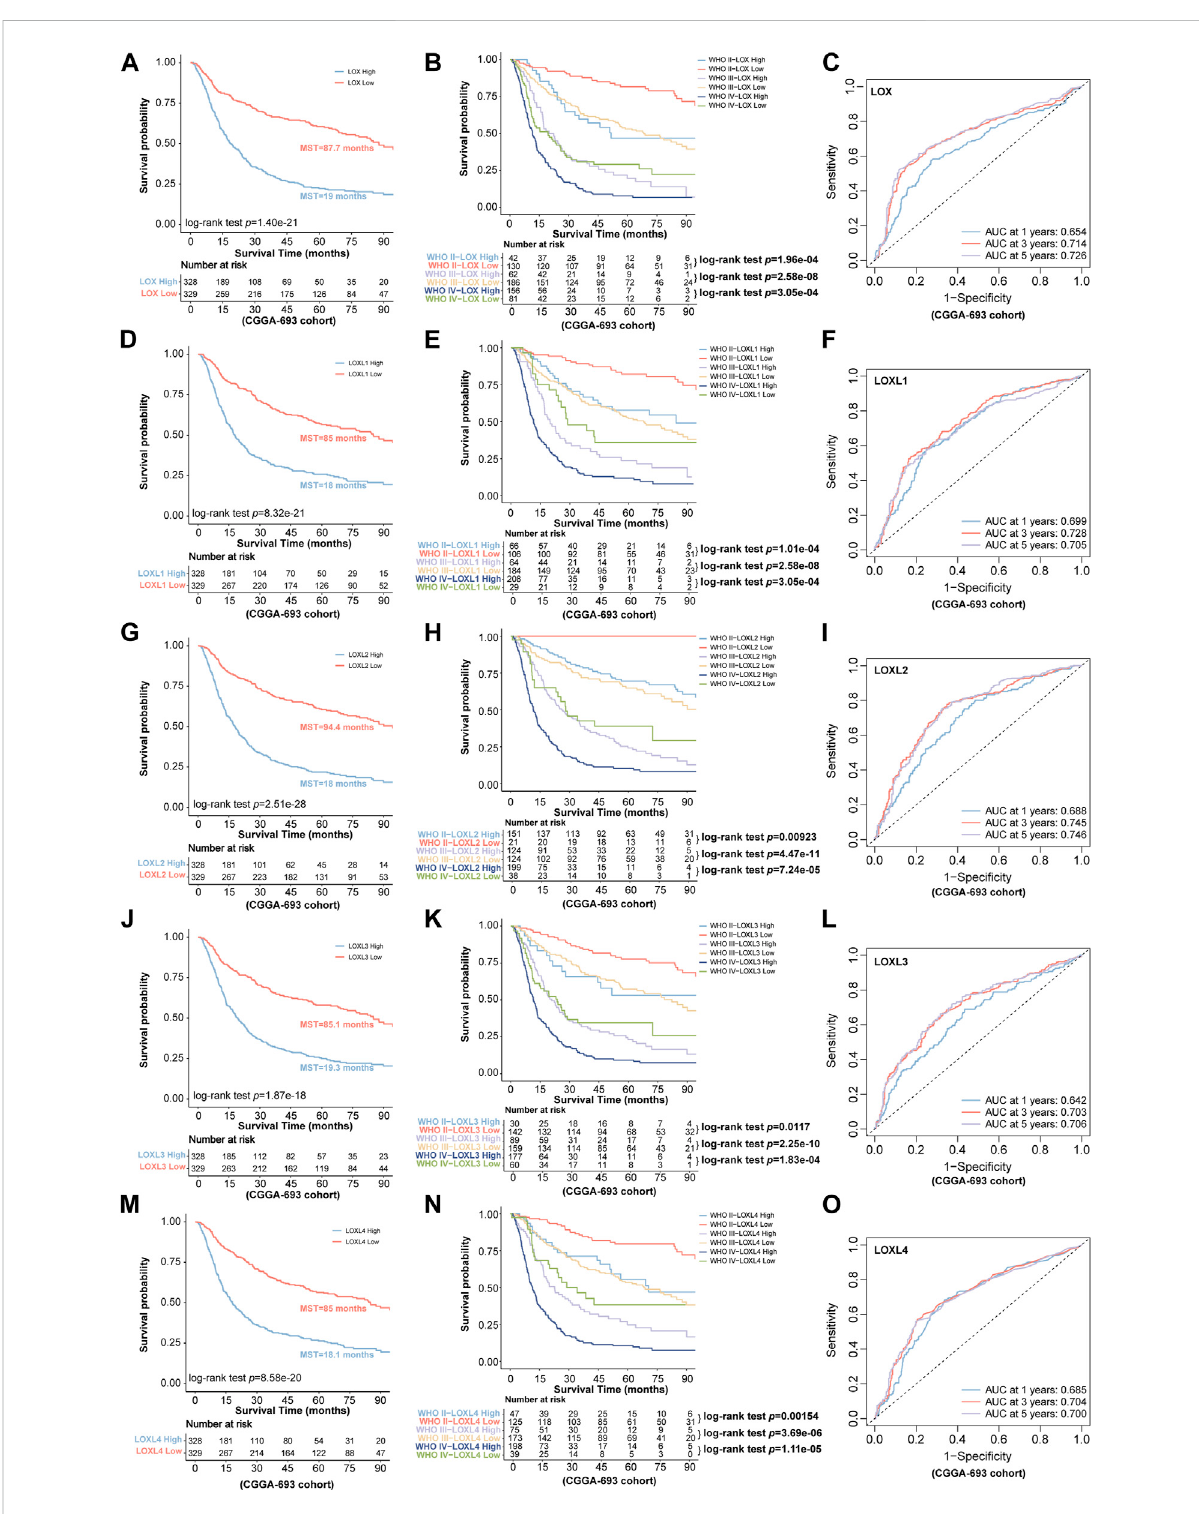
FIGURE 5 Validation of the predictive value for glioma via distinct LOXs expressions in CGGA-693 cohort. (A,D,G,J,M) the survival prediction via differential expressions of LOXs including LOX and LOXL1-4; (B,E,H,K,N) validation of the patients ’ prognosis with distinct LOXs expressions in differentgliomagrades; (C,F,I,L,O) evaluationofthepredictivevalueintheaspectof1 yearAUC,3 yearsAUCand5 yearsAUC via ROCcurveanalysis with distinct LOXs